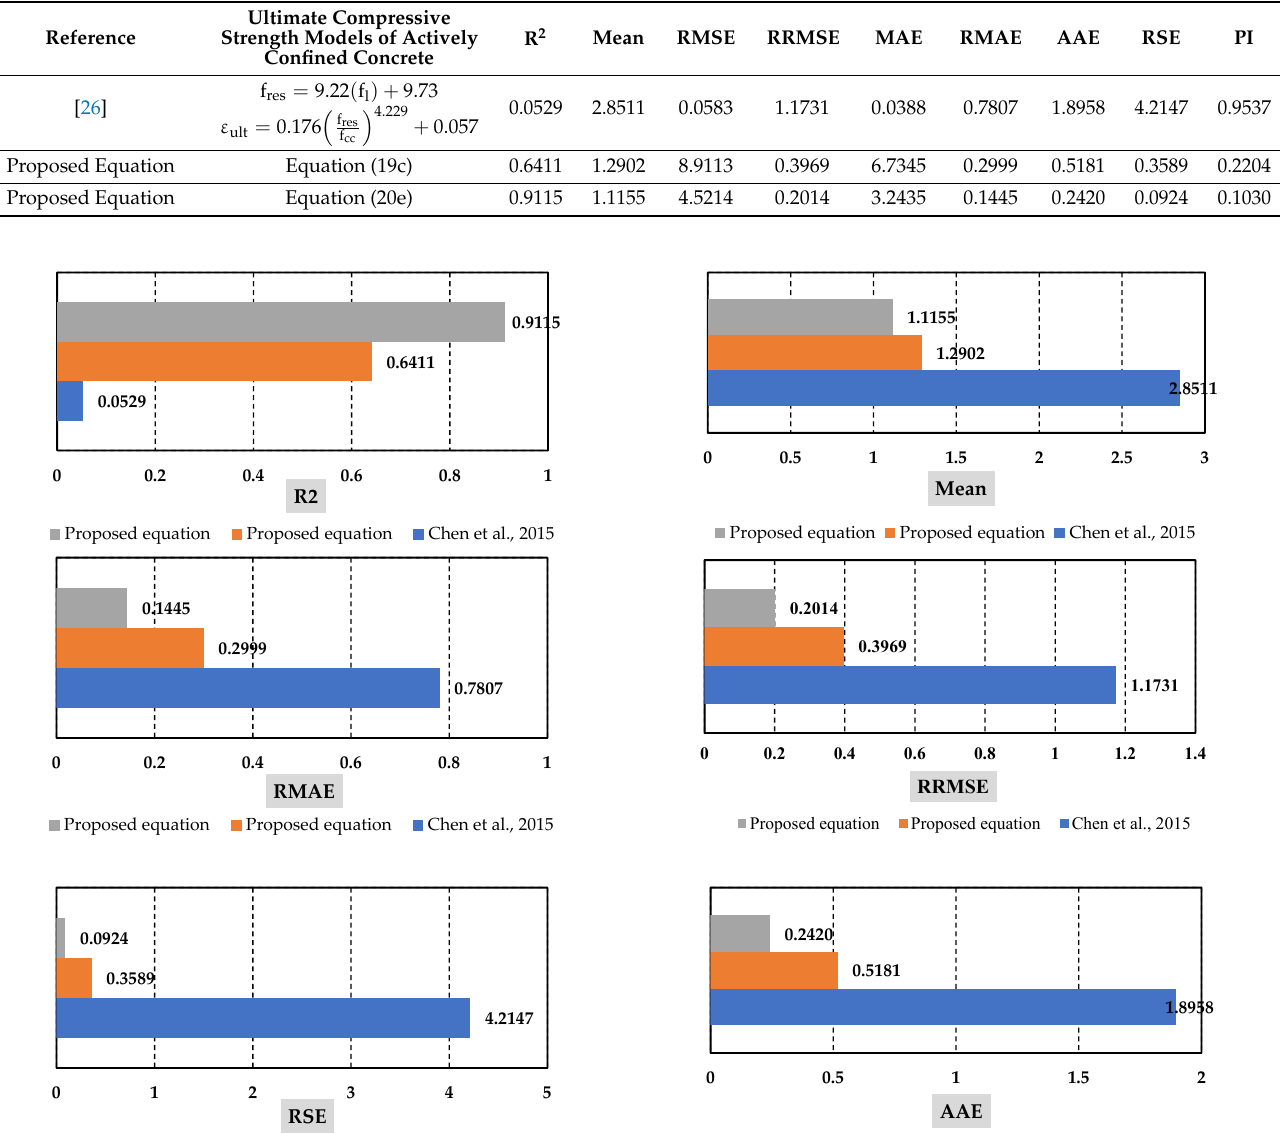
Table 16. Statistical indicators of ultimate strain models of SMA confined concrete.